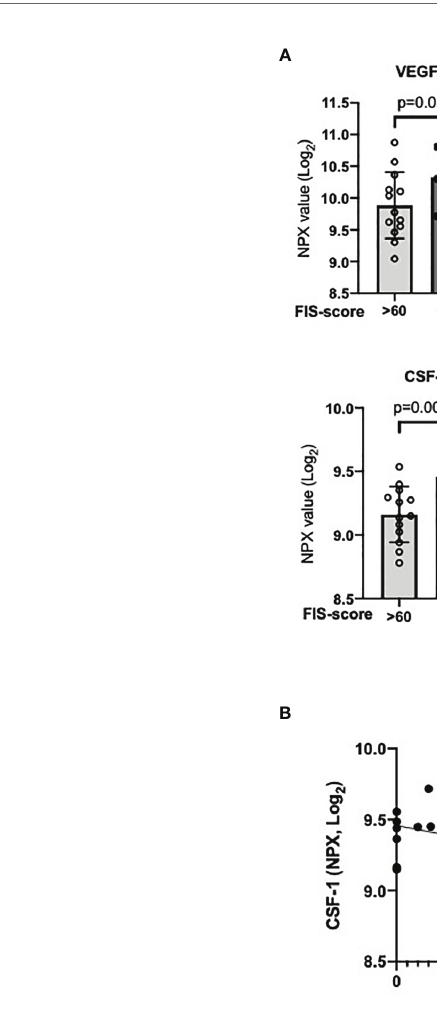
FIGURE 4 | Decreased plasma levels of in fl ammatory markers in IgGsd with severe fatigue. Plasma levels of the growth factors VEGFA, FGF-23, HGF and CSF-1, and TNF were found in IgGsd with severe fatigue (total FIS score >60, n=13) compared to IgGsd with total FIS score <60 (n=13) when off IgRT (A) . Plasma levels of CSF-1 correlated with total FIS score (B) . Data is presented as normalized protein expression (NPX) values in Log 2 scale. Error-bars indicate 95% CI, p represent student ’ s t-test. VEGF, vascular endothelial growth factor; FGF, fi broblast growth factor; HGF, hepatocyte growth factor; CSF-1, macrophage colony stimulating factor; IgGsd, IgG subclass de fi ciency; FIS, fatigue impact scale; IgRT, immunoglobulin replacement therapy; r, Spearman correlation coef fi